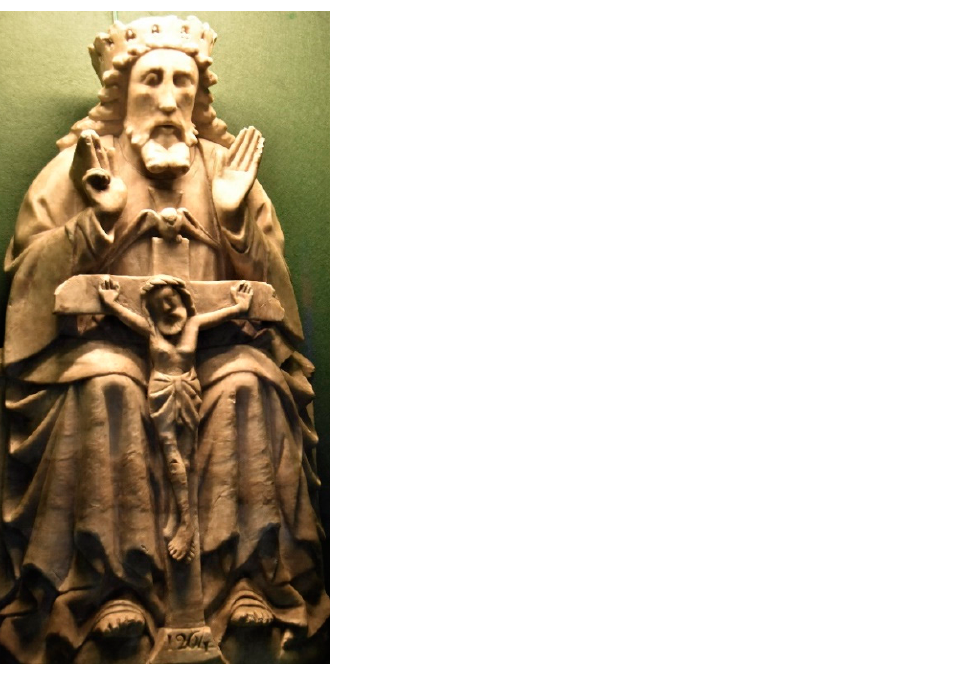
Figure 31. Throne of Grace, Black Abbey, Co. Kilkenny, first quarter of the fifteenth century. Photo- graph by the author.